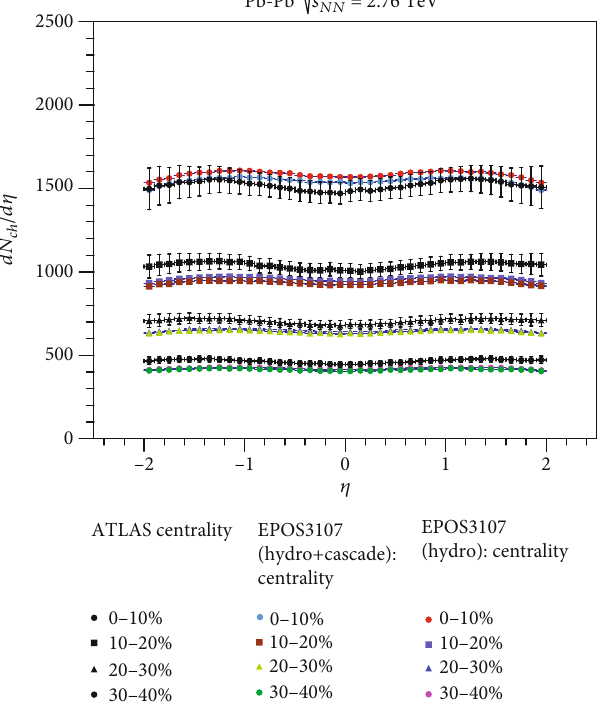
Figure 1: Charged particle pseudorapidity density distributions of EPOS3 (hydro) and EPOS3 (hydro+cascade) compared with that of the ATLAS data [20], for Pb-Pb collisions at